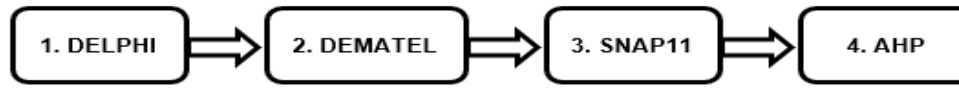
Figure 4. High-level components used in development of a new multicriteria model.